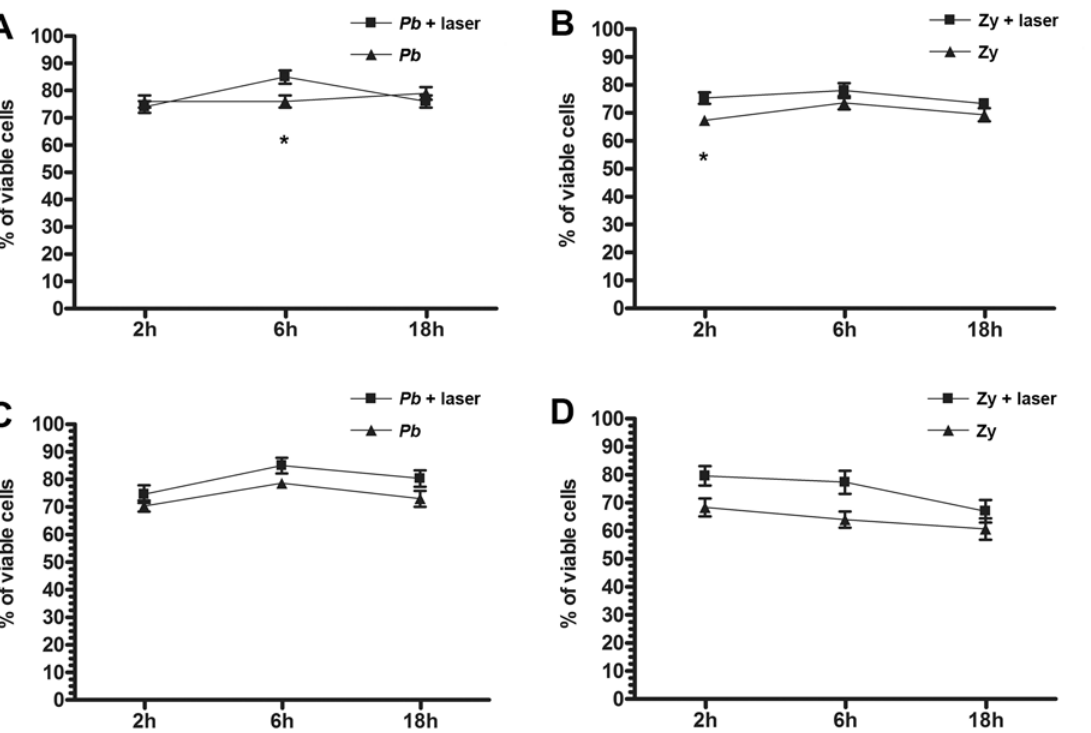
Fig 3. Kinetic behavior of PMN viability. Kinetics of PMN cell viability in irradiated and non-irradiated mice after stimuli with: A — Pb : higher viability for the irradiated PMN at 6 hours — p = 0.0278 ( * ); B — Zymosan: higher viability for the irradiated PMN at 2 hours — p = 0.0274 ( * ); C — Pb stimulated and co- cultivated with Pb ; D — Zymosan stimulated and co-cultivated with Pb